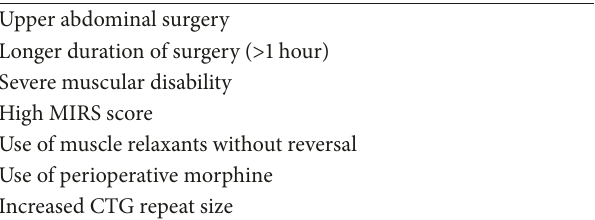
Table 4: Risk factors for perioperative complications [13,